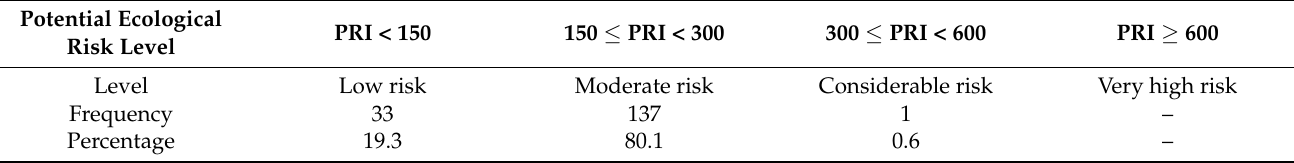
Table 5. Statistical analysis of the PRI values of the six heavy metals in the